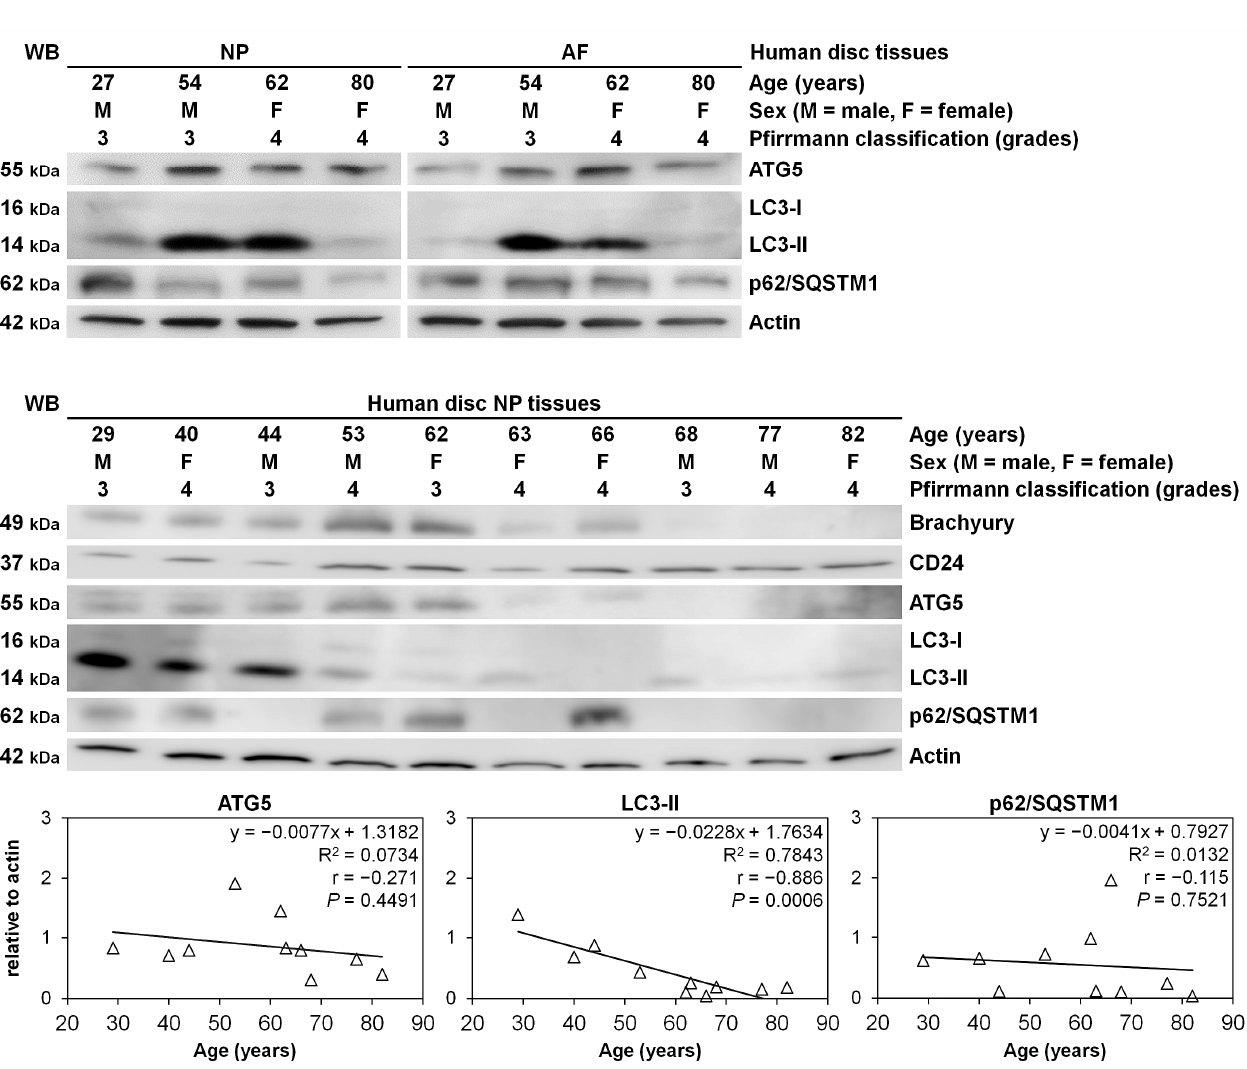
Figure 6. Modified autophagy-related protein expression based on the patients’ age in human disc NP tissues. ( A ) Western blotting for autophagic ATG5, LC3, and p62/SQSTM1 in total protein extract from human disc NP and AF tissues of patients who underwent lumbar spine surgery for degenerative disease. Actin was used as a loading control. Immunoblots show samples randomly selected ( n = 4). ( B ) Western blotting for disc NP-phenotypic brachyury and CD24, autophagic ATG5, LC3, and p62/SQSTM1, and loading control actin in total protein extracts from human disc NP tissues. Immunoblots show samples randomly selected ( n = 10). Protein expression levels of ATG5, LC3-II, and p62/SQSTM1 (normalized to actin) based on the patients’ age are shown. Regression analysis was used ( n = 10).